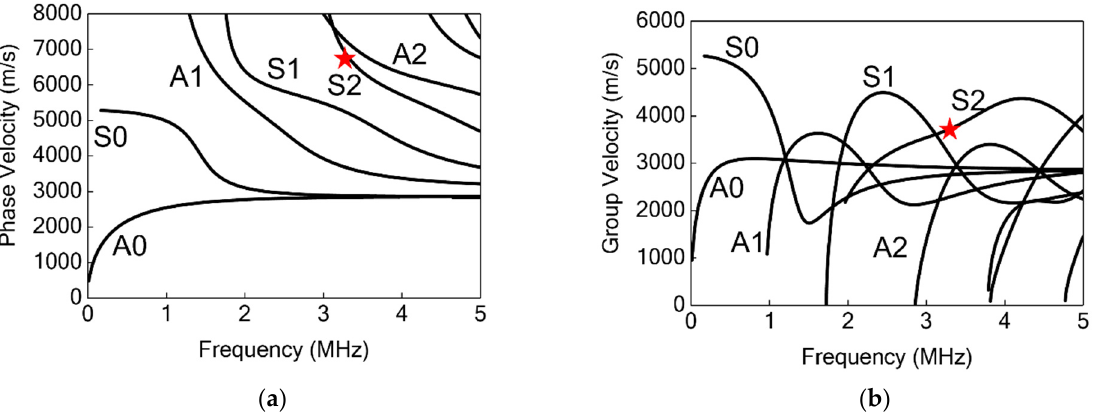
Figure 3. ( a ) Phase velocity and ( b ) group velocity dispersion curves for 1.6 mm-thick aluminum alloy plate. Here, A0, A1, and A2 are the antisymmetric Lamb wave modes; S0, S1, and S2 are the symmetric Lamb wave modes. The red star indicates the selected S2 mode at 3.2 MHz.